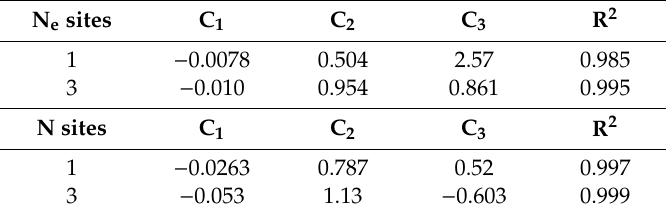
Table 3. Coe ffi cients and R 2 values of Y max polynomial interpolation from Figure 6 for N and N e